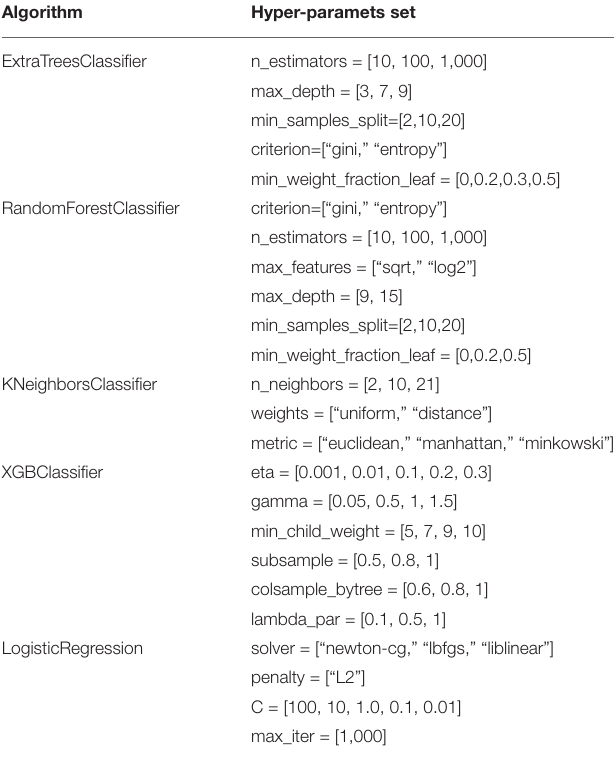
TABLE 2 | Sets of hyper-parameters used for the grid-search corresponding to the pre-selected classification algorithms.